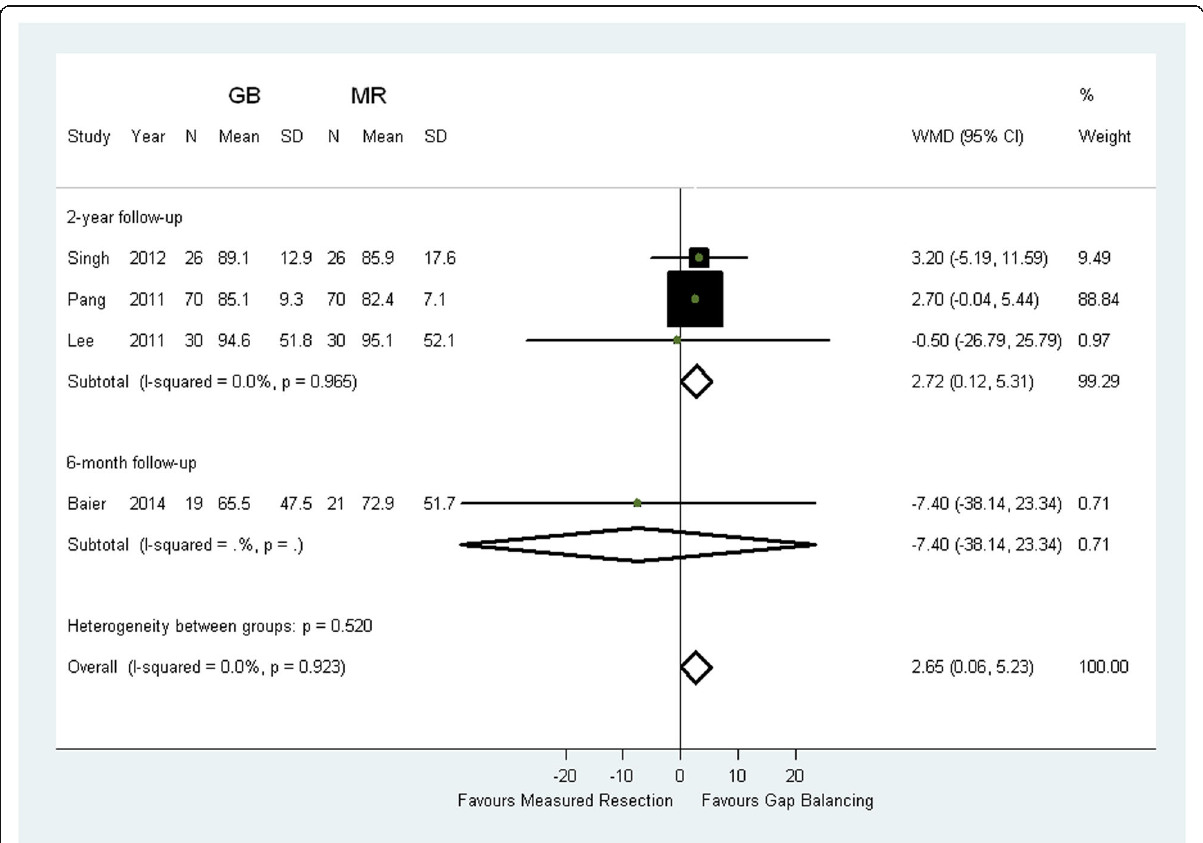
Fig. 2 Comparison of KSS scores for pain between measured resection (MR) group and gap balancing (GB) group. SD = standard deviation, CI = confidence